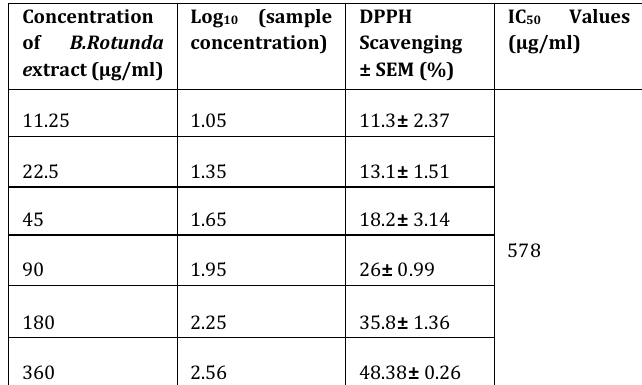
Table 2: B. rotunda ethanolic extract DPPH test.